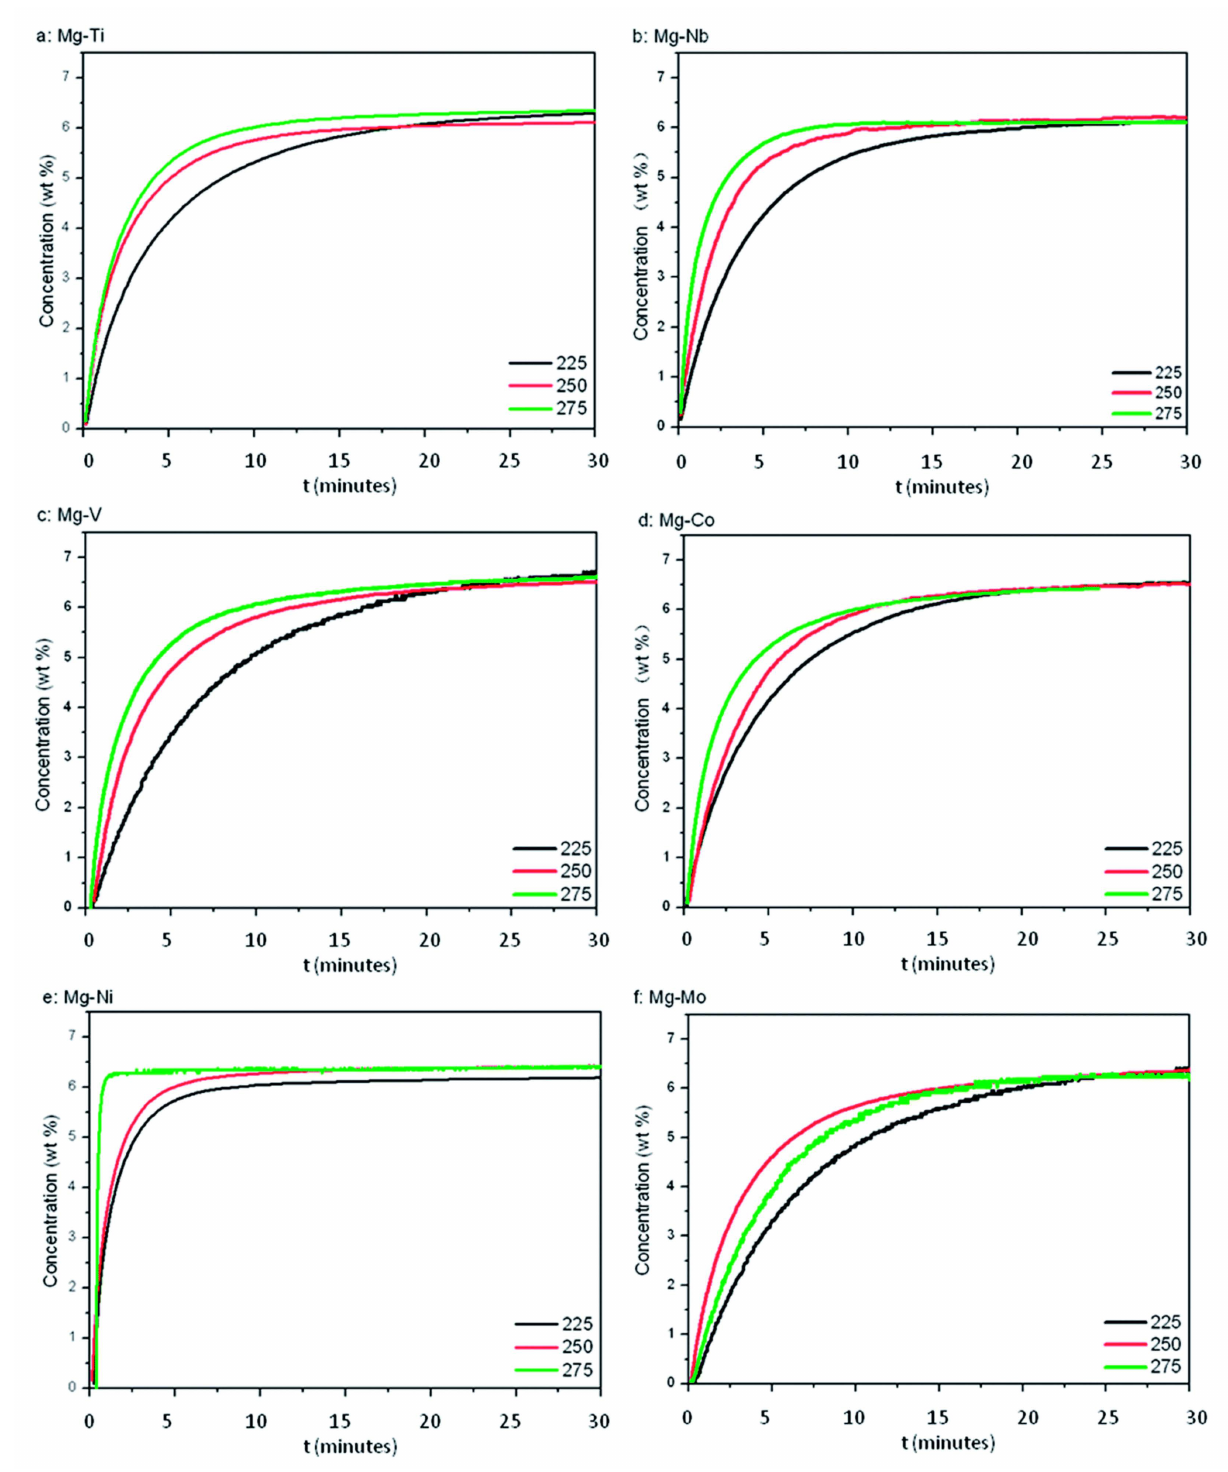
Figure 10. Isothermal hydrogenation curves of Mg–TM samples at 225, 250 and 275 ◦ C. ( a ) Mg–Ti; ( b ) Mg–Nb; ( c ) Mg–V; ( d ) Mg–Co; ( e ) Mg–Ni; ( f ) Mg–Mo [104]. (Reprinted with permission from the Royal Society of